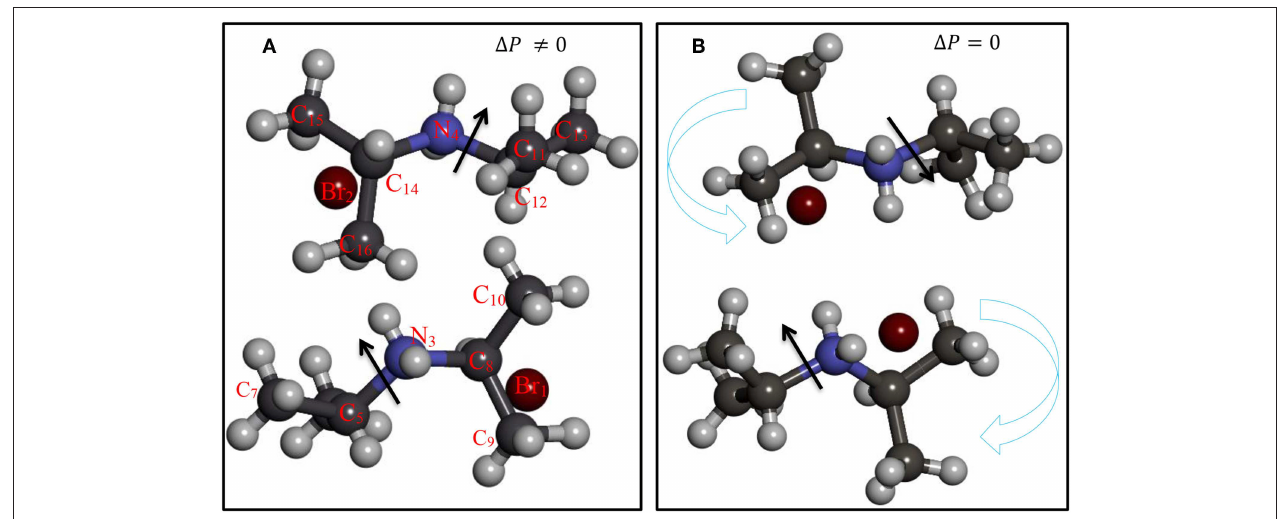
FIGURE 1 | Structures of (A) α -DIPAB phase and (B) and P 2 1 / m (β) phase.